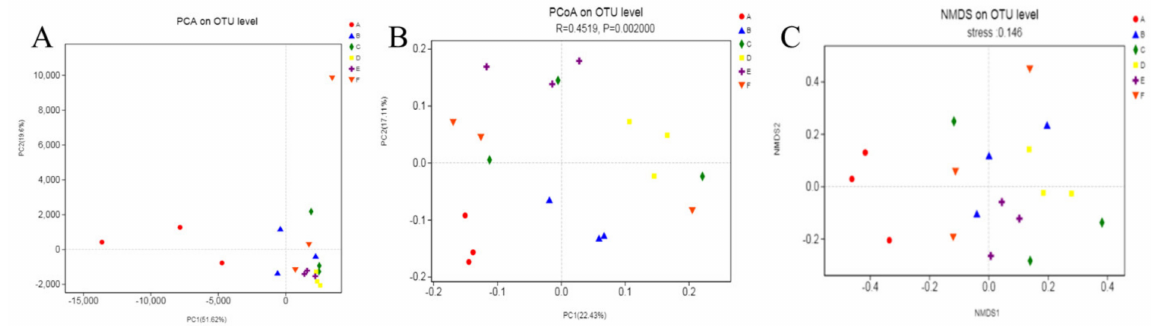
Figure 10. PCA ( A ), PCoA ( B ), and NMDS analysis ( C )